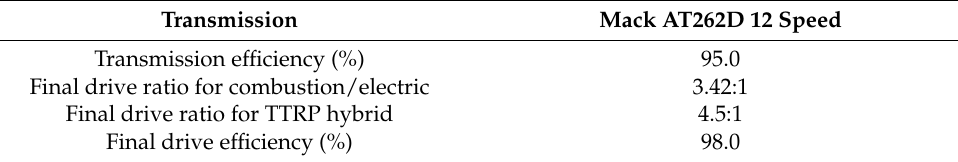
Table 2. Multi-articulated vehicle specifications.